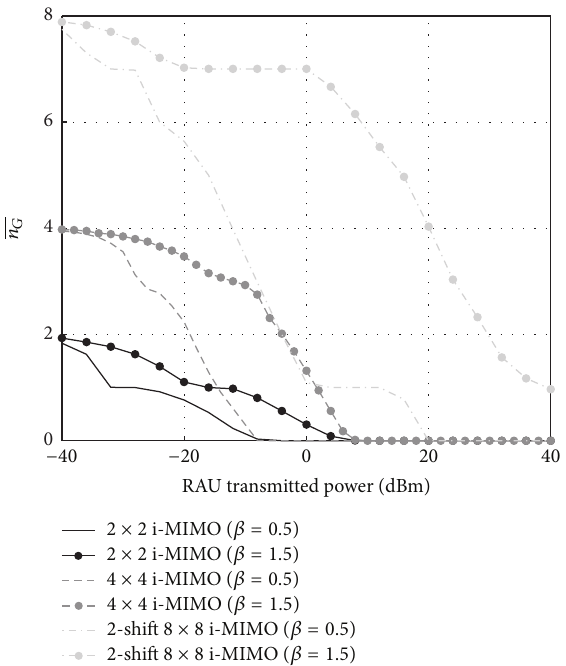
Figure 11: Comparison of 2-, 4-, 8-branch i-MIMO DAS average performance in the 2D deployment case. Average number of branches under threshold ( 𝑛 𝐺 ) is shown, for different values of the propagation model parameters (RAU antenna distance: 20 m).